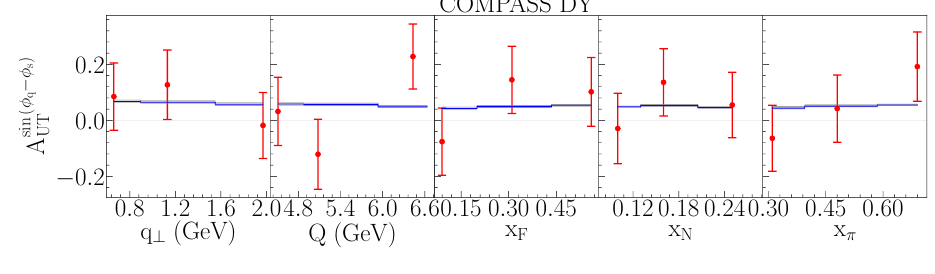
Figure 11 . COMPASS Drell-Yan measurement for π − - p collision [46] as a function of q ⊥ , Q , x F , x N , and x π from left to right. The central curve as well as the uncertainty band are generated using the result from fit 1 in table 1.